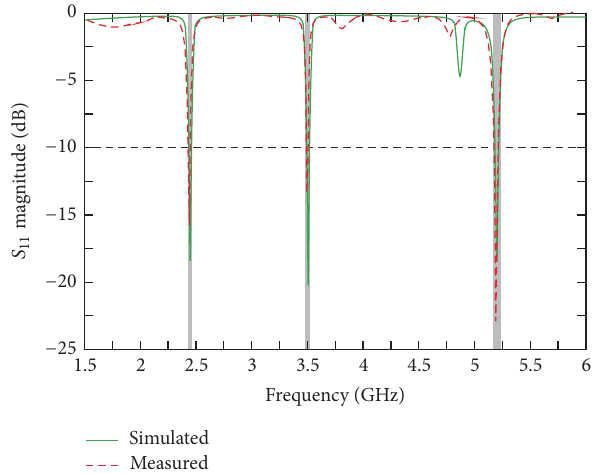
Figure 3: Frequency response of the designed antenna shown in Figure 1.